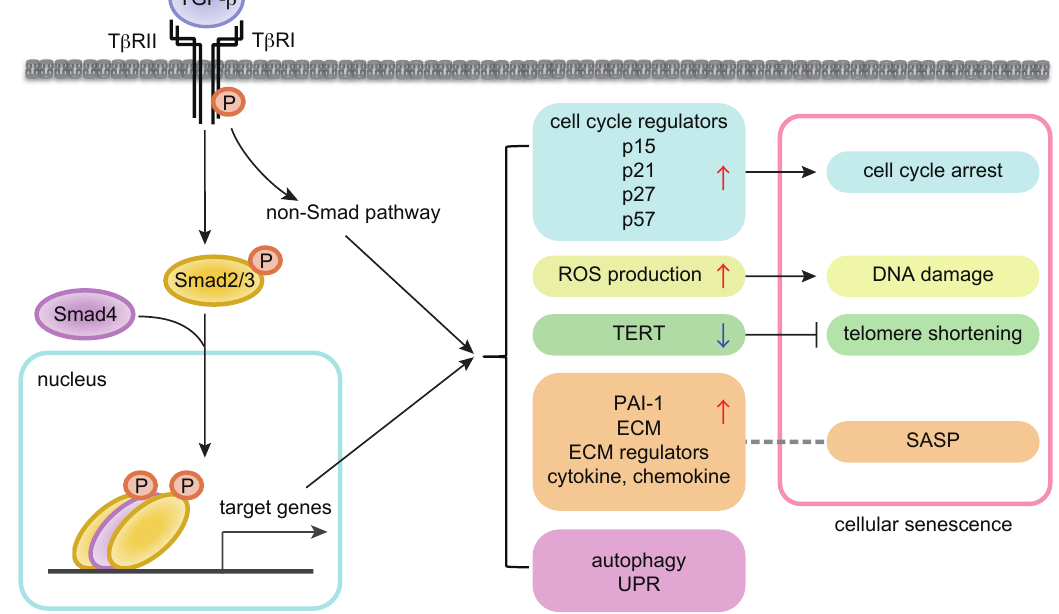
Figure 1. TGF- β (transforming growth factor- β ) signaling in cellular senescence. ( Left ) Intracellular signal transduction cascades by TGF- β . ( Right ) The link between TGF- β signaling and senescence modulators. The arrows and T bar indicate enhancement and suppression, respectively. A dot line indicates the relationship between TGF- β downstream targets and Figure 2